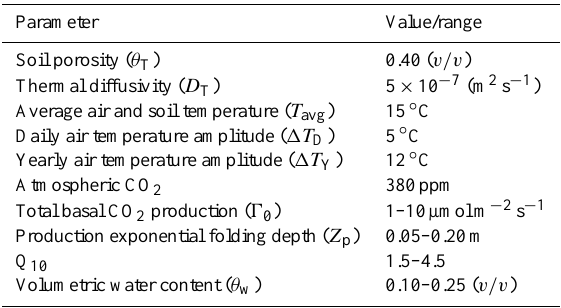
Table 1. Default parameter values for simulations. Parameter